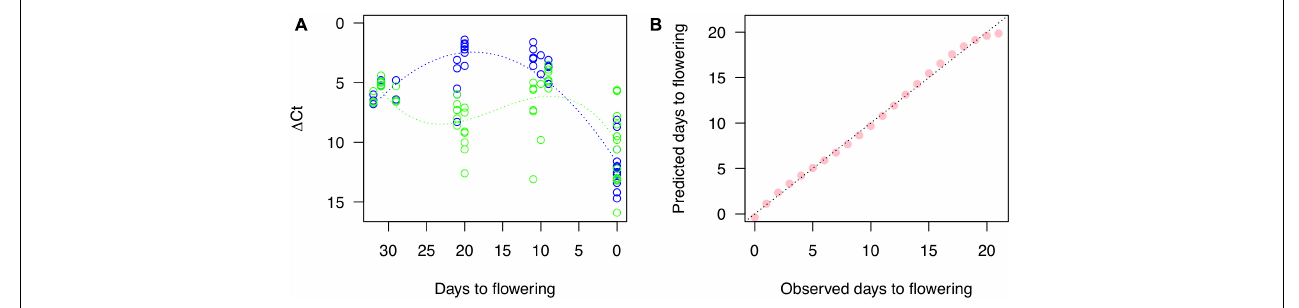
FIGURE 4 | Gene expression quantified by RT-PCR and a fitness of the model for cherry blossom forecast based on the RNA expression. (A) Blue and green dots show expression level of genes for CYE_r3.1SPA4_g005220.1 (CBFb) and CYE_r3.1SPA0_g059890.1 (CBFg), respectively, related to a control gene, CYE_r3.1SPA3_g018730.1 (CBFr). Blue and green lines indicate non-linear regression curves. (B) Correlation between observed days to flowering and those predicted by the model for cherry blossom forecast established with a generalized linear